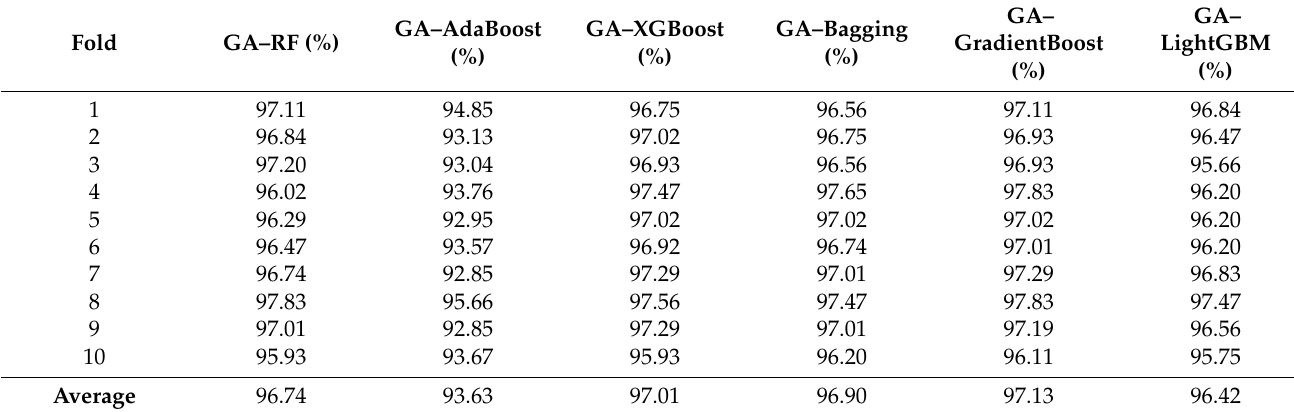
Table 7. The accuracy of the optimized ensemble models for Dataset 1.